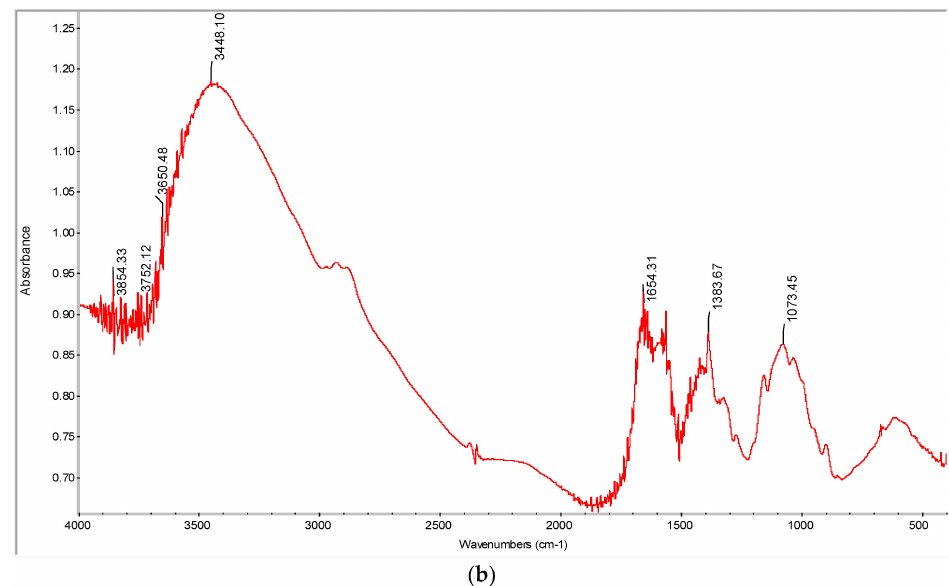
Figure 3. ( a ) FTIR spectra of chitosan from carapace of M. rosenbergii ; ( b ) FTIR spectra of commercial chitosan.